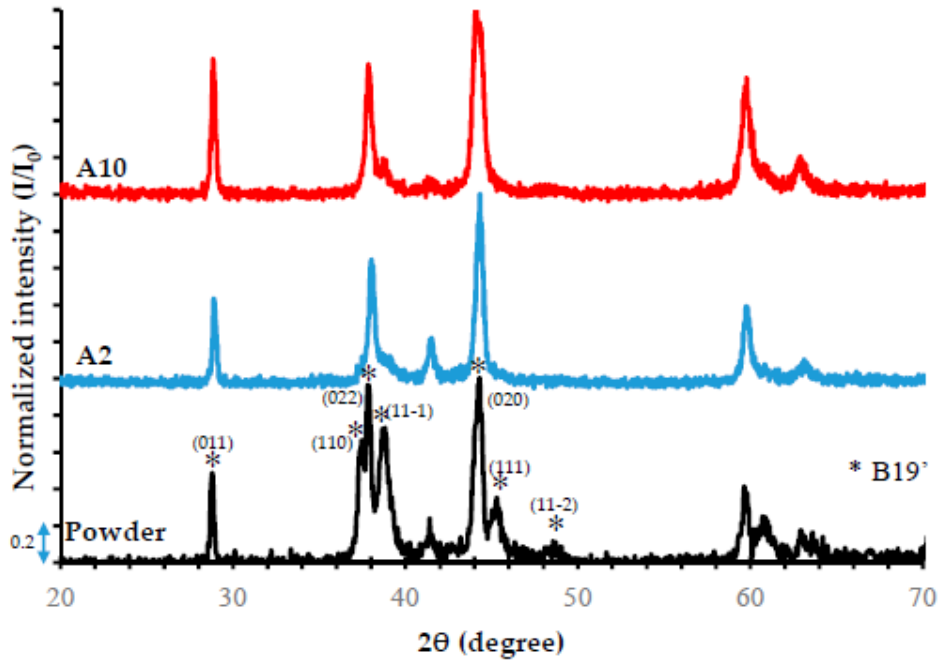
Figure 8. Normalized XRD patterns of A2 and A10 samples at room temperature (RT). The NiTiHf powder spectra at room temperature is also provided for comparison.